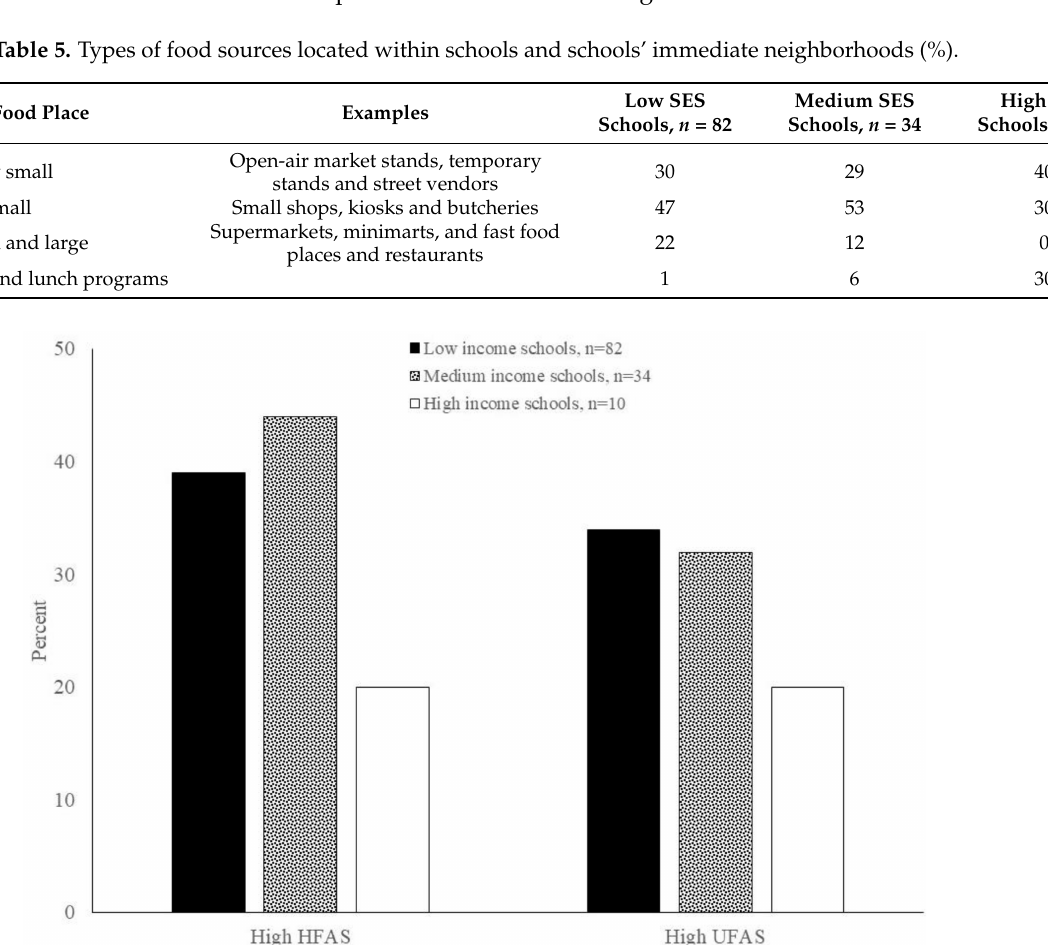
Figure 2. Percentage of food places within schools and schools’ immediate neighborhoods that had high healthy availability scores (HFAS) and high unhealthy availability scores